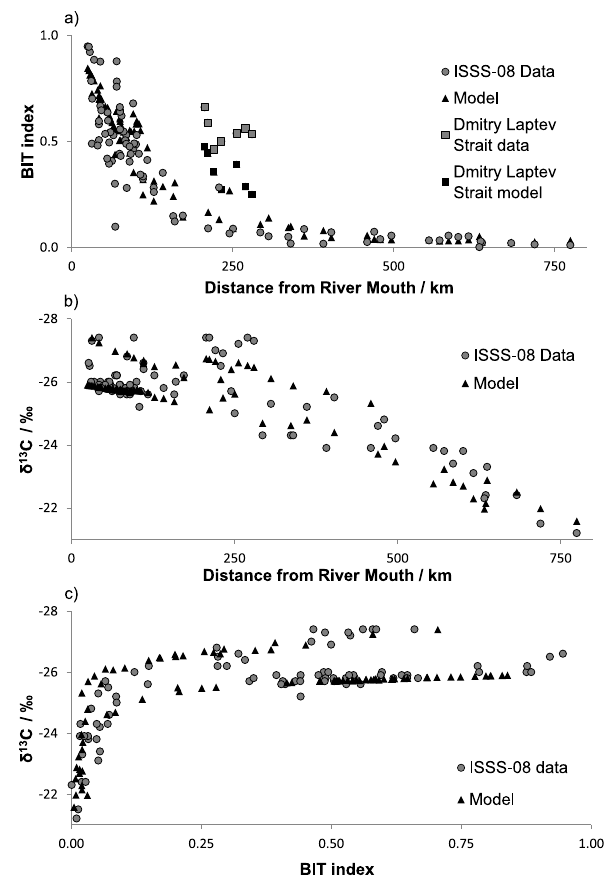
Figure 7. Comparison plots of sample parameters with modelled values. Grey symbols represent observed data from this study and Vonk et al. (2012); black symbols are modelled values. (a) BIT in- dex vs. distance from river outflows. Samples from the DLS are shown separately, demonstrating how this region is offset from the general offshore-reduction trend in BIT, and showing the model recreating this trend. (b) δ 13 C vs. distance from river outflow. (c) δ 13 C vs. BIT